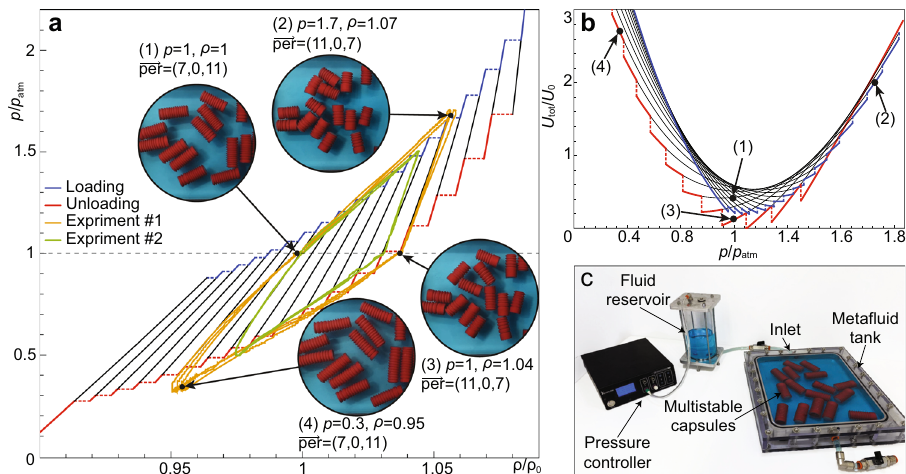
Fig. 4 Pressure cycles and experimental demonstration. a Experimental and theoretical pressure ( p / p atm ) vs. density ( ρ / ρ 0 ) cycles. The black, blue, and red curves represent (analytically calculated) equi-permutation lines, loading, and unloading modes, respectively. Orange and green curves represent the experimental results (each curve containing three cycles). Representative frames (circular insets) taken from our experiment correspond to points (1) – (4) on the ; p open = (0.26 ml, 26.24 kPa) and ( v II ; p close orange curve. In the experimental data, snap-open and snap-close points are ( v I ) = (1.04 ml, − 16.61 kPa), s ) s s s respectively. The slopes of the tri-linear approximation are k I = 2300 kPa ml − 1 , k II = 152 kPa ml − 1 , for phase I and II, respectively, and the number of bi-stable elements per capsule is 18. b The corresponding internal energy of the system, where points (1 – 4) correspond to the frames in a . c Experimental setup: the pressure controller, which is responsible for regulating the (constant) pressure in the fl uid reservoir, is connected to the meta fl uid tank inlet via a fl ow valve. The height of the fl uid in the fl uid reservoir is monitored in the experiment to allow measuring the change in equivalent density of the meta fl uid. See Supplementary Movies 1 – (cid:2)(cid:2)! ¼ ð ; 1 ; n Þ become stable as the density of the fl uid form per n I II increases (see insets within Fig. 3b). The red curve in Fig. 3b, presents modi fi ed k II . In this case, a permutation with unstable element ( n s = 1) results in a stable state of the system. The insets show that decreasing v atm or increasing k II creates regions where the fl uid is stable although a bi-stable element is at the spinodal region. In both panels, several stable densities are possible for a given pressure, as sible densities per a given pressure, we need to reach the speci fi c well as several pressures for a single density. This feature appears for permutation on which the desired density-pressure point is unstable curves with positive slopes.